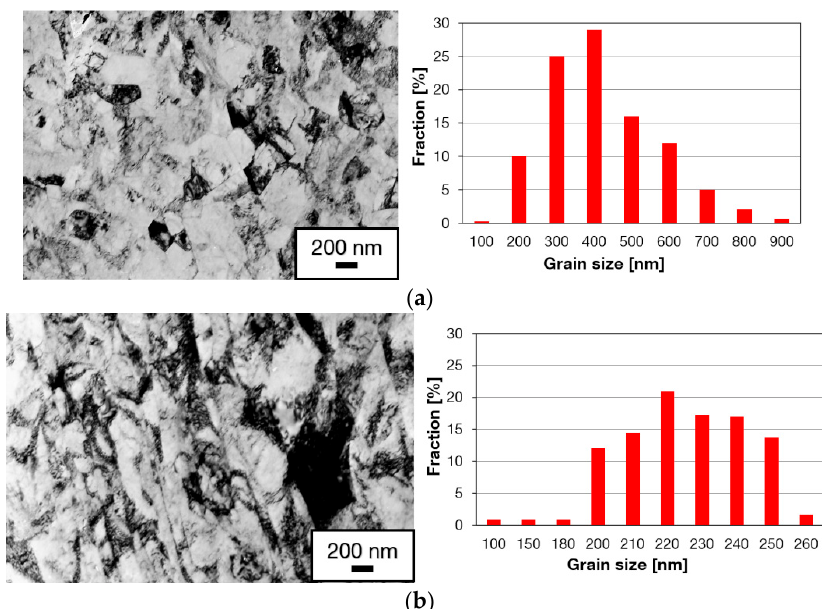
Figure 6. Substructure and grain size histogram after three passes through the Conform SPD and rotary swaging (60% reduction of cross-sectional area): ( a ) in the transverse direction; ( b ) in the longitudinal direction.